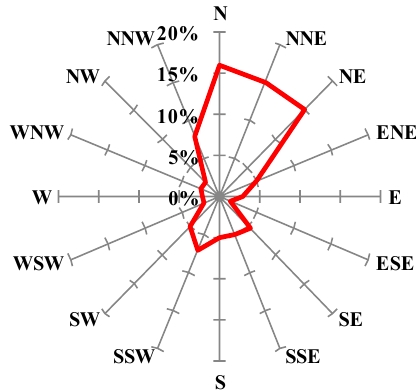
Figure 1. The wind rose diagram in 2013, Wuhan (calm wind frequency was 2.15%) 2.2 Sampling site and method.